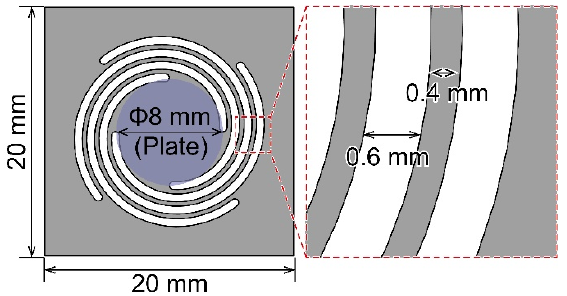
Figure 3. Detailed design of the planar spring.